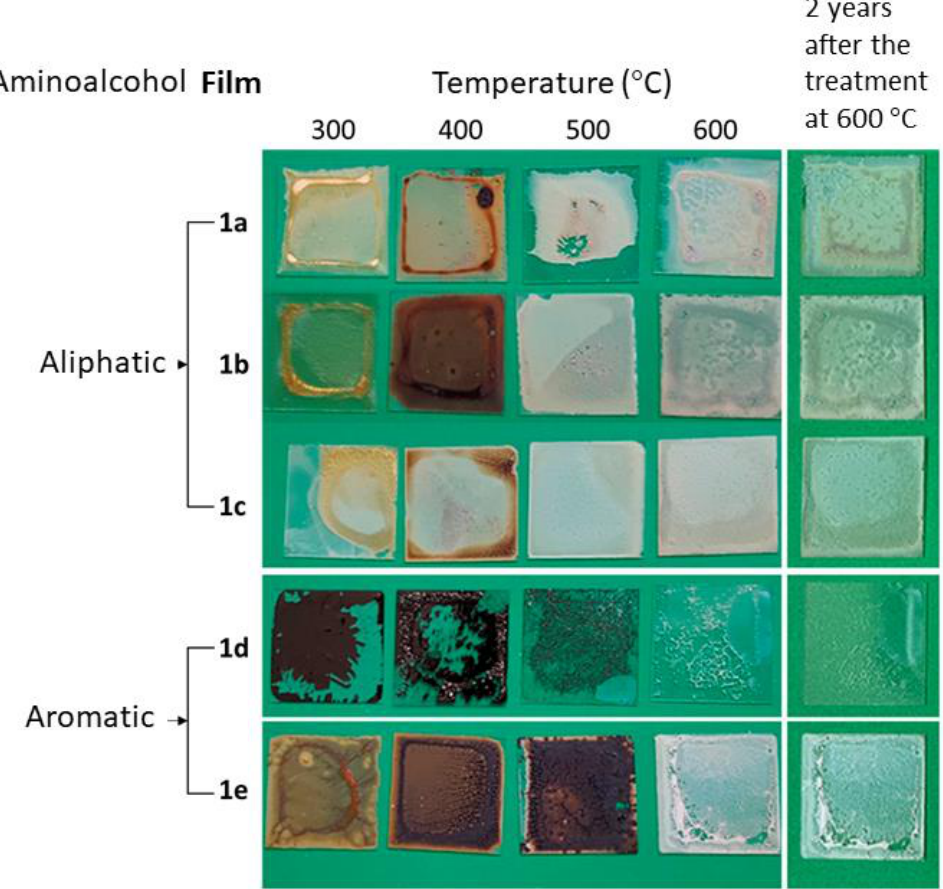
Figure 2. Physical appearance of the films 1a–1e annealed at 300, 400, 500, and 600 °C, and after two years’ storage at room conditions in the dark.